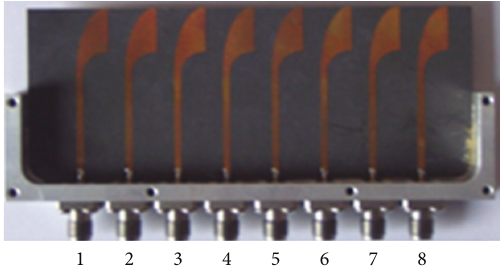
Figure 7: The ADE-TSA array with 8 elements.